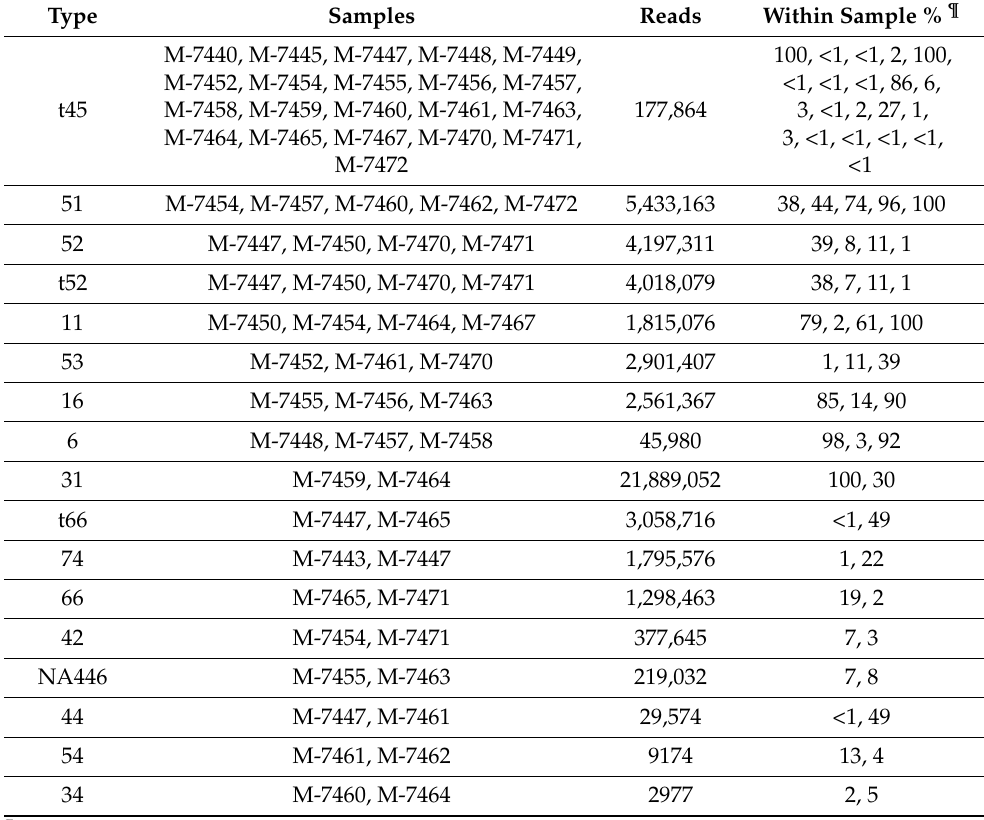
Table 2. Detected HPV types in two or more